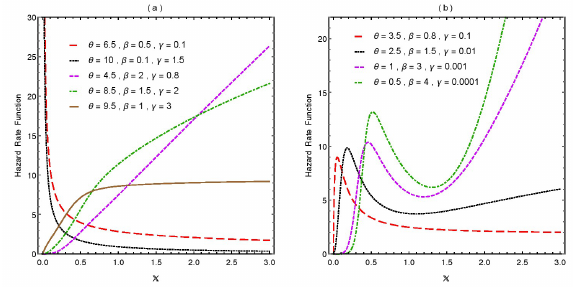
Fig. 2. The MOPA hazard rate function patterns. pdf is tilted to the right, monotonically decreasing, and unimodal, or has a reversed J-shaped